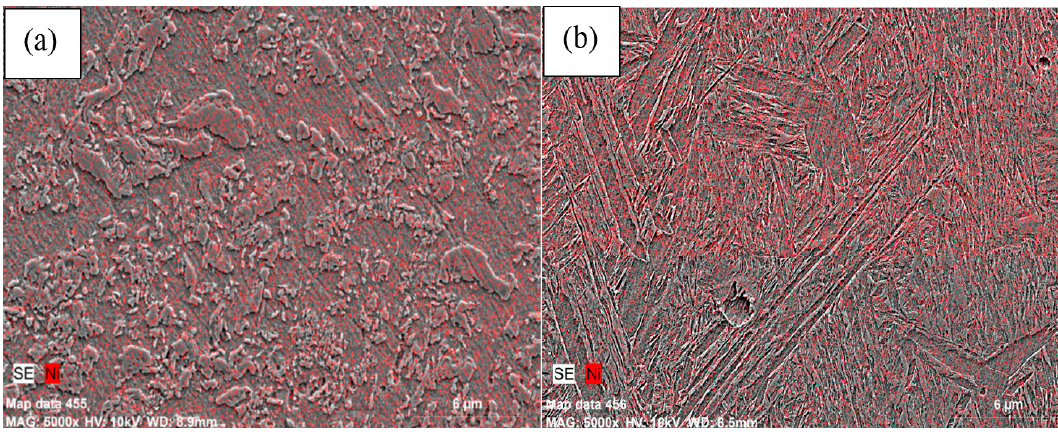
Figure 4. Elemental mapping for ( a ) alloy 3 and ( b ) alloy 4 sintered at 1400 °C.